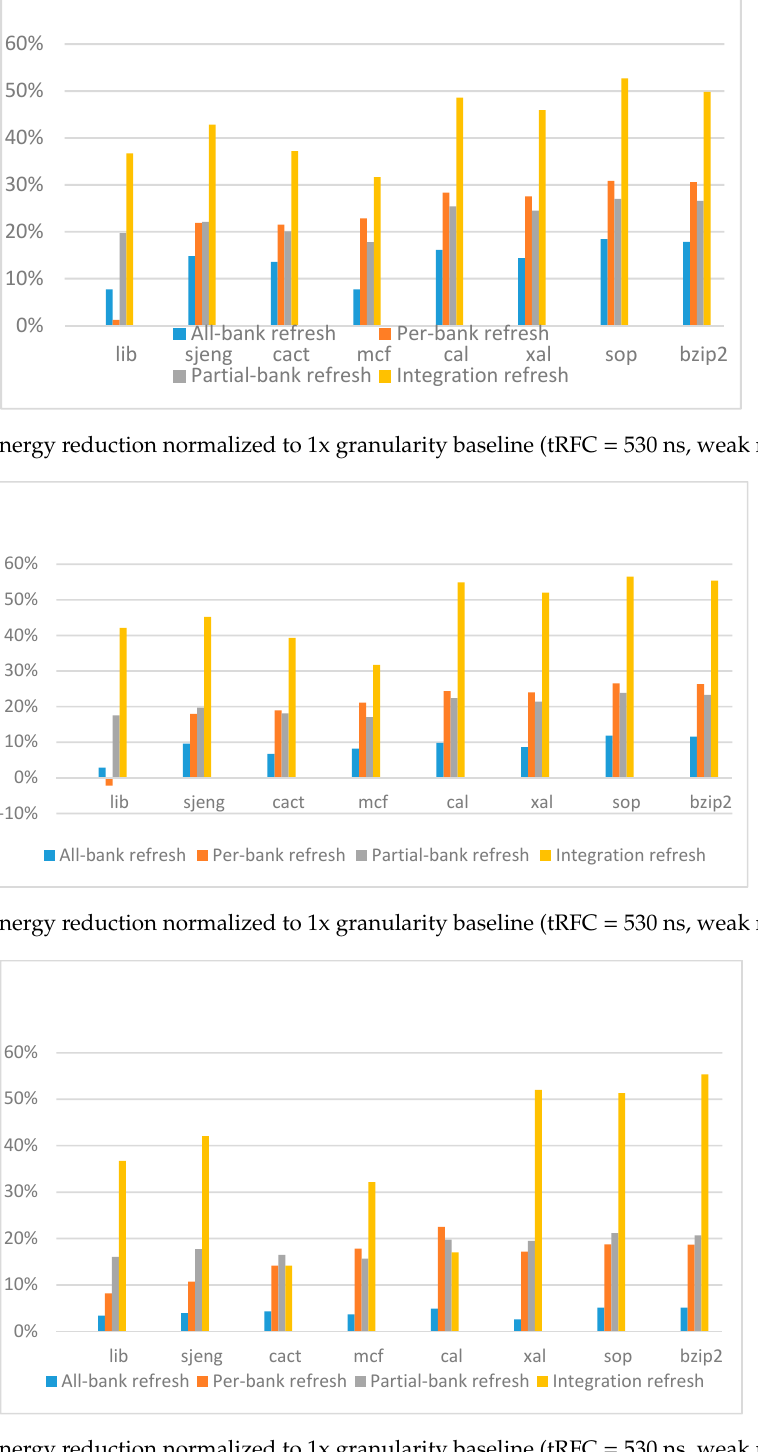
Figure 25. Energy reduction normalized to 1x granularity baseline (tRFC = 530 ns, weak row = 5%).